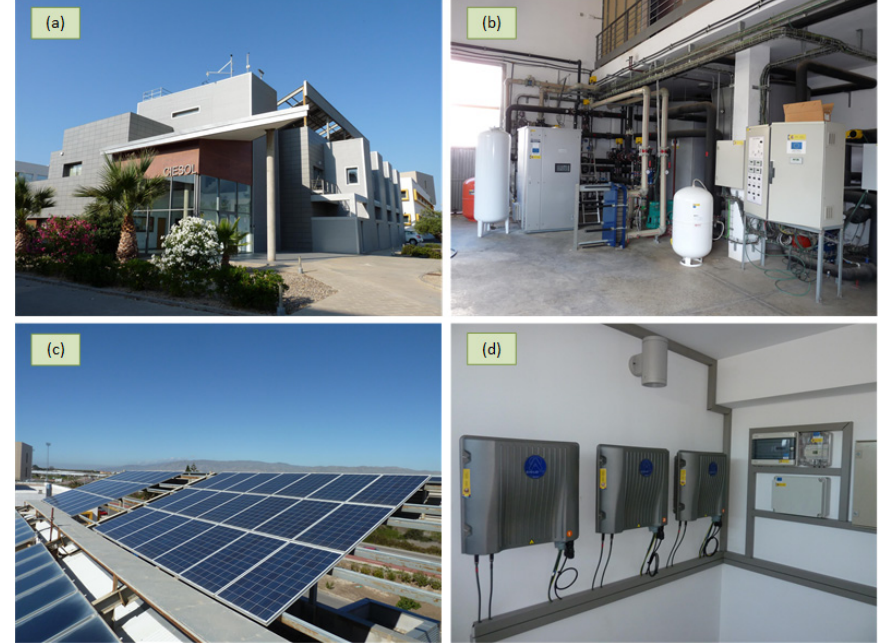
Figure 1. The Solar Energy Research Center (CIESOL or Centro de Investigación en Energía SOLar in Spanish) building: ( a ) exterior of the CIESOL building; ( b ) solar cooling installation; ( c ) photovoltaic (PV) power plant: PV panels; and ( d ) PV power plant: PV inverters.